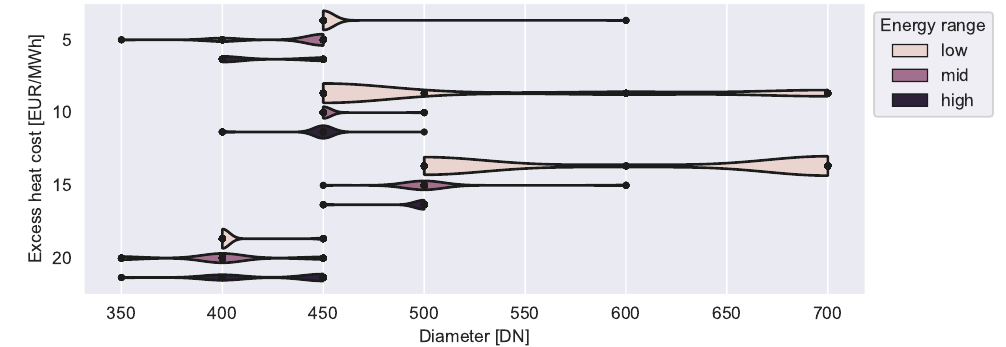
Figure 20. Influence of the excess heat cost on the diameter of the connection between the excess heat injection node and the rest of the